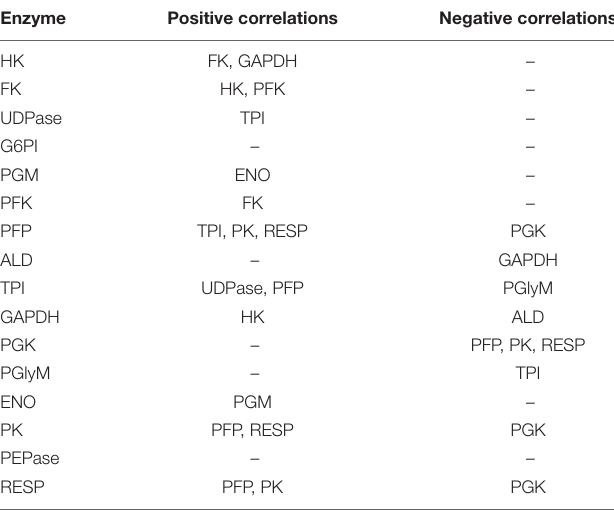
TABLE 2 | Significant correlations between glycolytic enzyme activities and respiration rate (RESP) in roots during 60 days storage ( α =